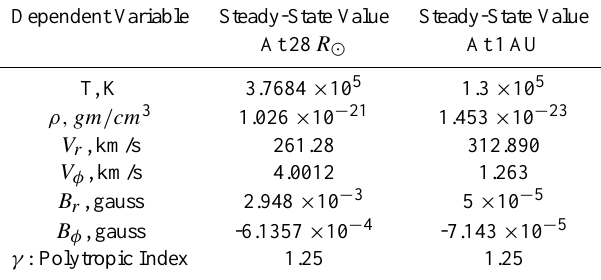
Table 1. Summary of steady-state solar wind values at 28 R (cid:12) and 1AU.